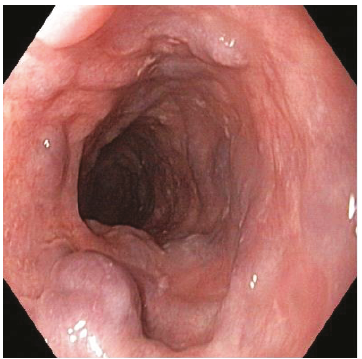
Figure 2: Type II downhill varices. Endoscopic appearance.